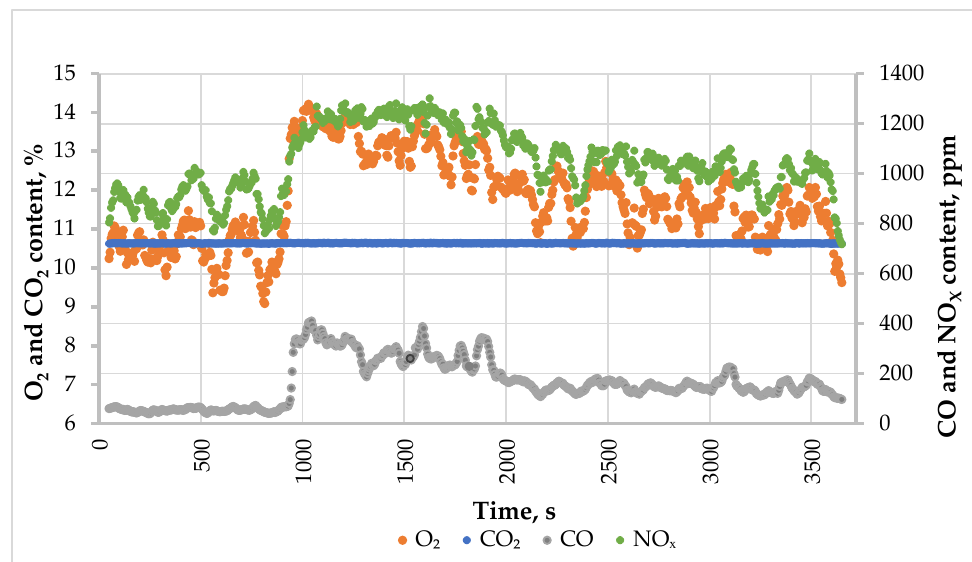
Figure 5. Chemical composition of flue gases during the combustion of wood-based waste pellets.